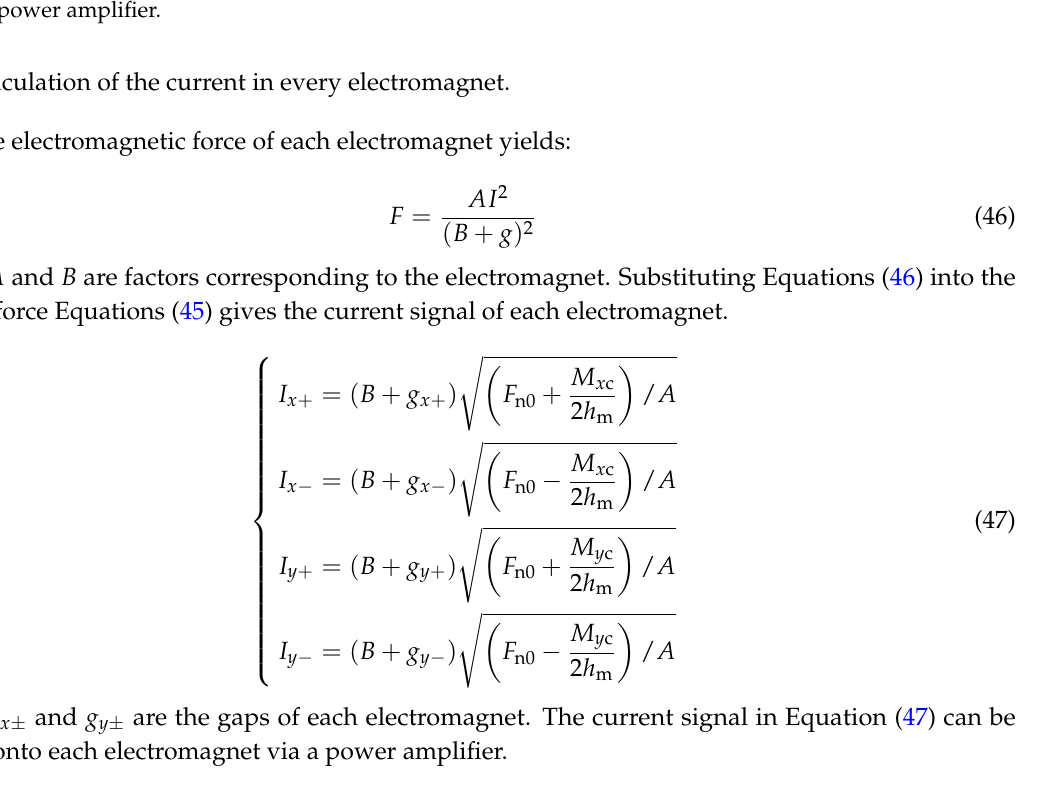
Block diagram of the orientation experiment: ( a ) gap sensor; ( b ) electromagnet; ( c ) rotor; ( d ) gap calculation; ( e ) angle calculation; ( f ) controller; ( g ) control current.